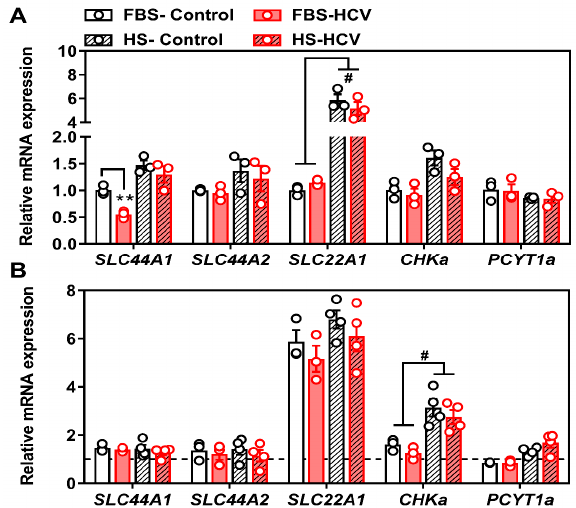
Figure 2. Choline transporter mRNA expression at 24 and 96 h post-HCV infection. FBS- and HS-cultured Huh7.5 cells were infected at an MOI of 1 for ( A ) 24 or ( B ) 96 h before cells were washed and RNA isolated to measure choline transporter ( SLC44A1 ; choline transporter-like 1, SLC44A2; choline transporter-like 2 and SLC22A1; organic cation transporter 1) as well as CDP-choline pathway ( CHKa ; choline kinase alpha and PCYT1a ; phosphocholine cytidylyltransferase alpha) transcript expression. All groups are shown relative to uninfected FBS-cultured control cells at 24 h and normalized to the average of β ACTIN and HSP90 . The hashed line in (B) represents the level of uninfected FBS-cultured control cells at 24 h. Data are mean ± SEM and represent three independent experiments. Statistical significance was determined by two-way ANOVA with a Tukey post-hoc analysis (within each transcript), such that ** represents p < 0.01 compared to uninfected control within serum culture condition and # represents p < 0.05 compared between FBS- and HS-cultured